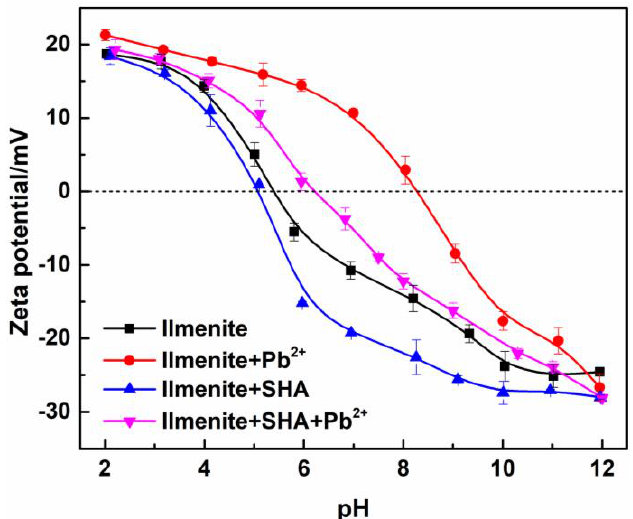
Figure 5. Zeta potentials of ilmenite as a function of pH (C (Pb 2+ ) = 1 × 10 −4 mol/L. C (SHA) = 2 × 10 −4 mol/L).